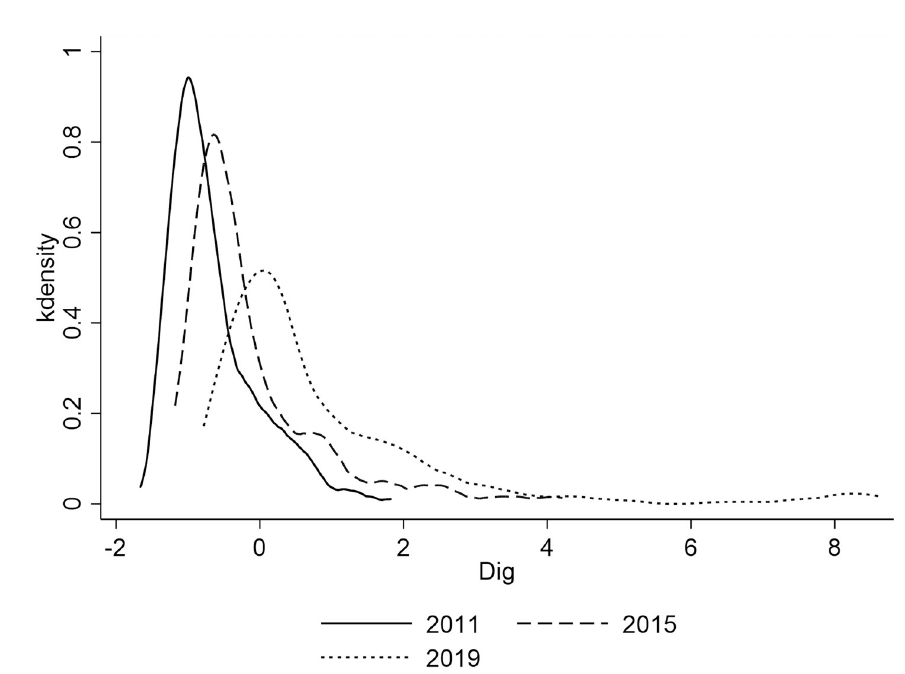
Fig 2. Kernel density estimation of the digital economy by year.